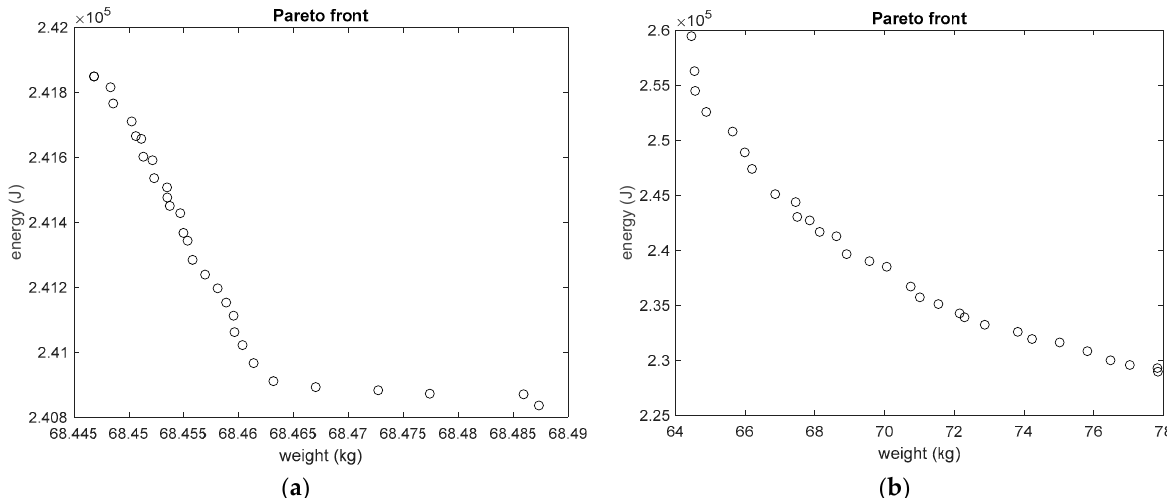
Figure 9. The Pareto front obtained from the EHA optimization design. ( a ) The Pareto front by considering design robustness. ( b ) The Pareto front without considering the design robustness.